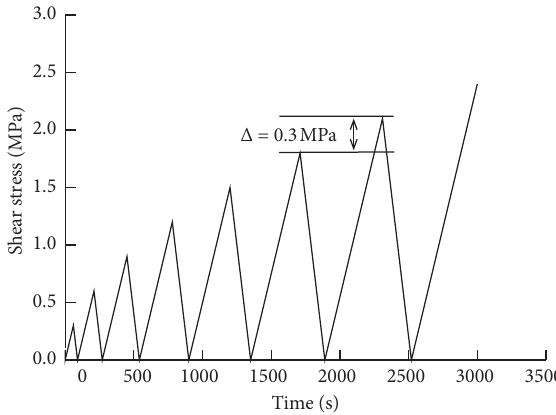
Figure 6: The tiered loading-unloading cycles for shear